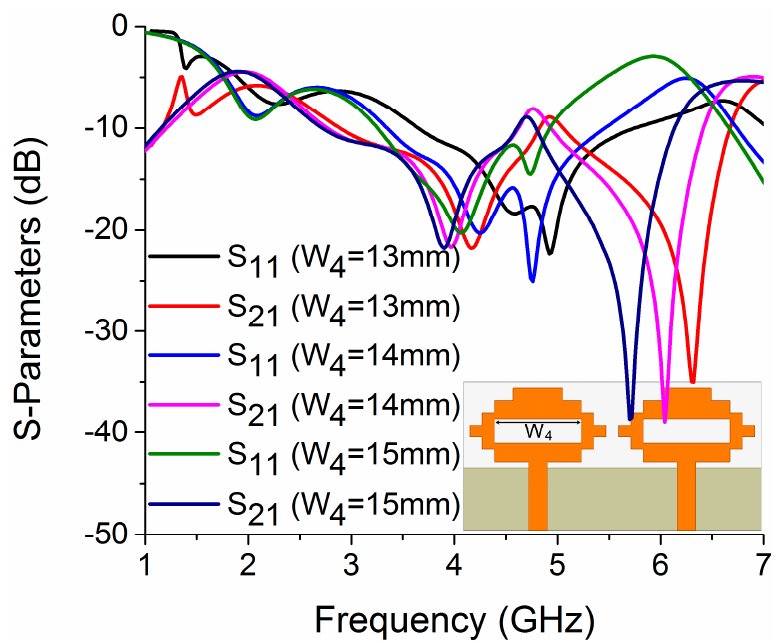
Figure 18. Influence of W 4 on S-parameters.